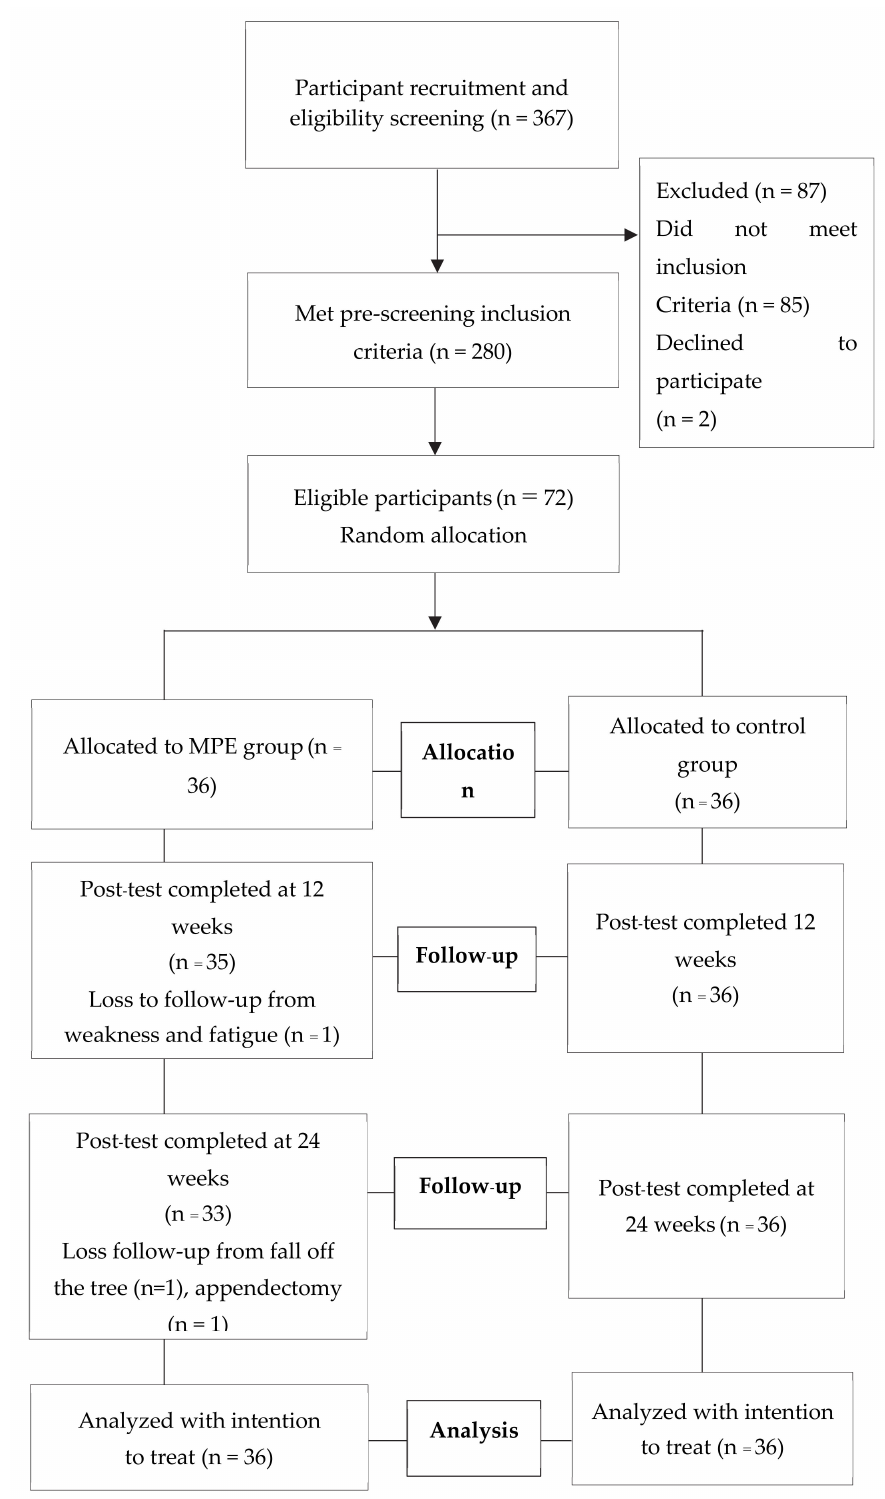
Figure 1. The flow diagram of the participants through each stage of the study. The sample size was based on an estimated minimally required sample size for analysis. G*power software version 3.0 was used, and 33 participants per group were needed for a two-tailed at 5% significance level, anticipated e ff ect size = 0.71 [31], with a statistical power level of 80%. Allowing for a 10% dropout rate, 36 subjects were recruited into the